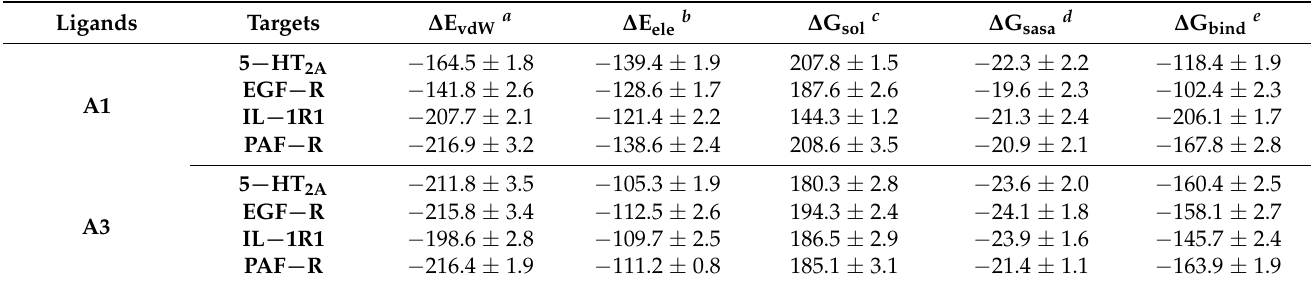
Table 5. Binding-free and related energies (kJ/mol) calculated by the molecular mechanics/Poisson– Boltzmann surface area (MM/PBSA) method for the top-ranked, best-docked compounds within the binding sites of four protein targets.